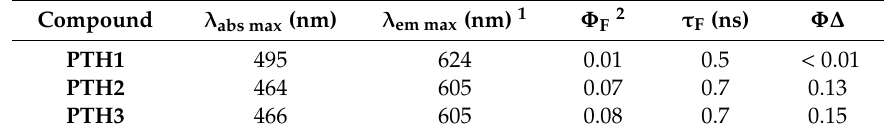
Table 2. Optical characteristics of phosphonium-based polythiophene CPEs in